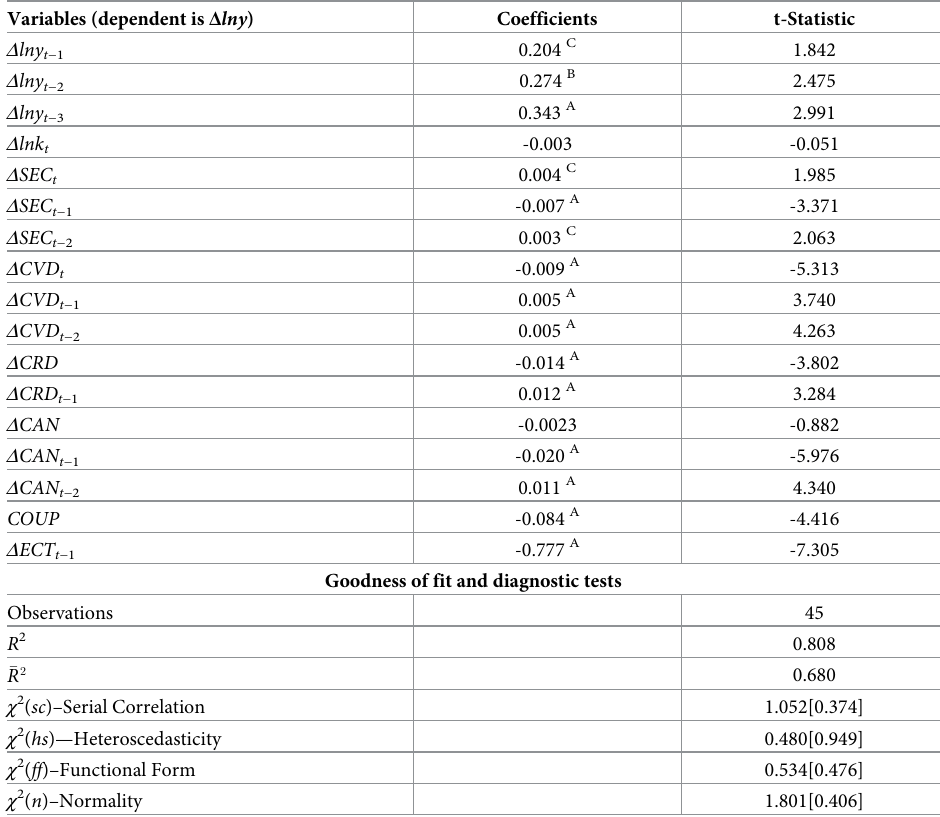
Table 8. Short-run results of model (5), 1972–2016.